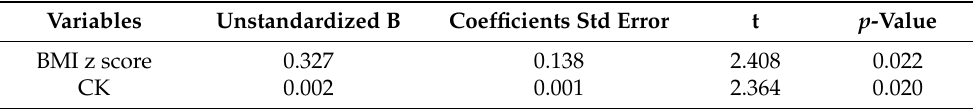
Table 4. Multiple linear regression for LV mass z score in child age.